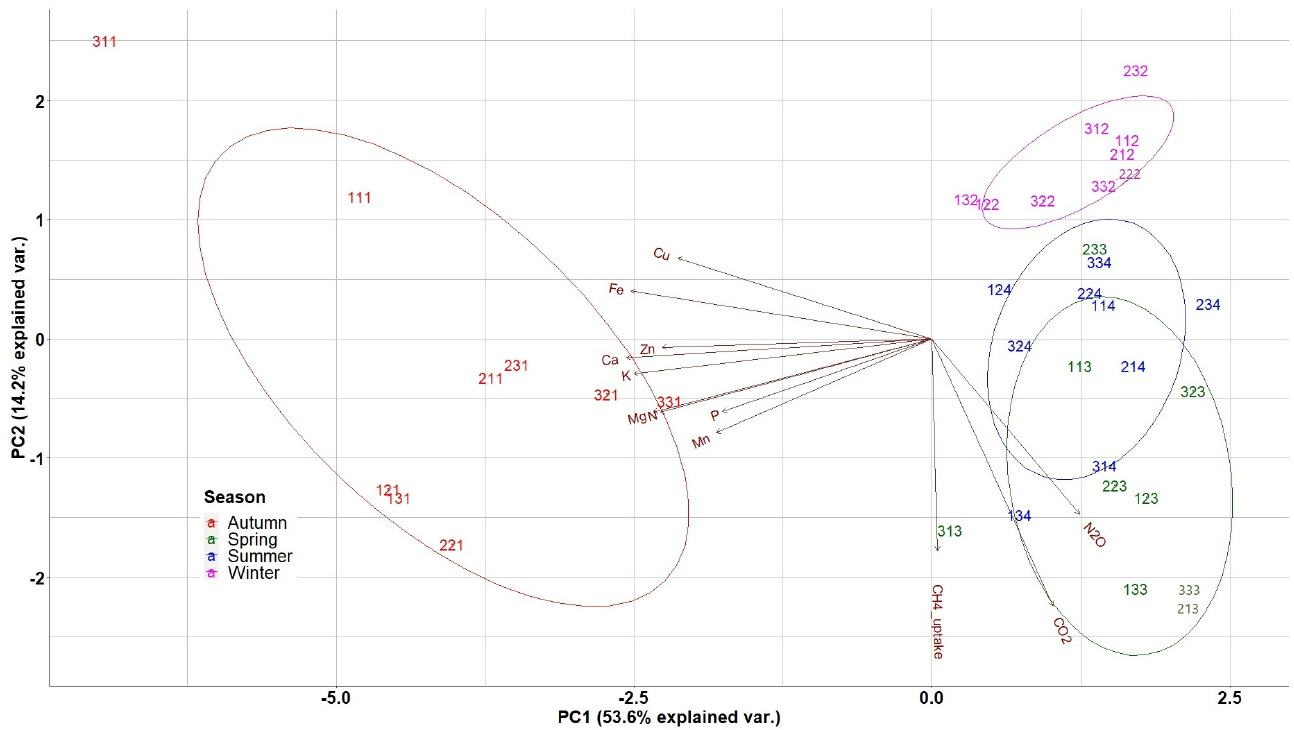
Figure 6. Distribution of nutrients and GHGs in the two first PCA axes for litterfall data. N: Nitrogen, P: Phosphorus, K; Potassium, Ca: Calcium, Mg: Magnesium, Cu: Copper, Fe: Iron, Mn: Manganese, Zn: Zinc. The 3 digit numbering of the data points represents: the first digit the repetition, the second the treatment (1: Traditional; 2: Selective; 3: Control) and the third digit the season (1: Autumn; 2: Winter; 3: Spring; 4: Summer).